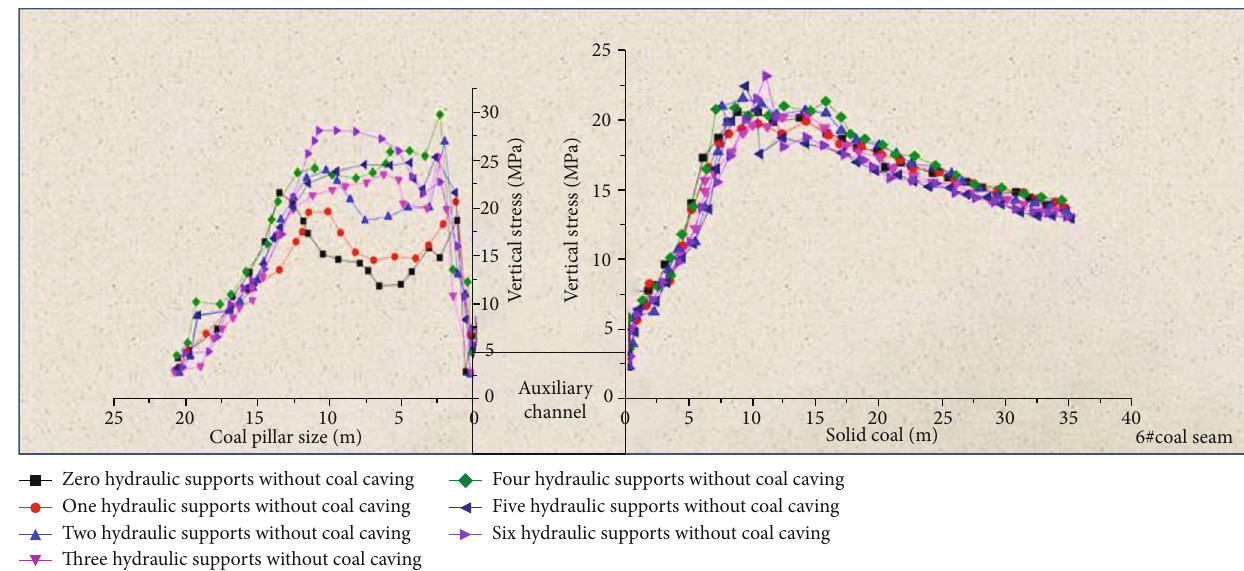
Figure 13: Change of vertical stress of solid coal on the right of coal pillar and roadway with length of end empty section (20 m coal